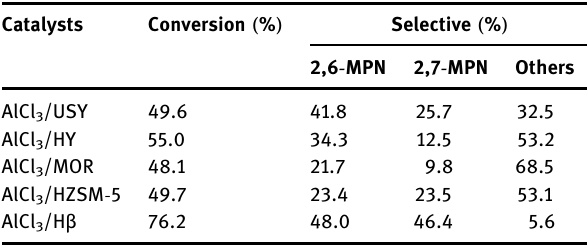
lyzed by AlCl 3